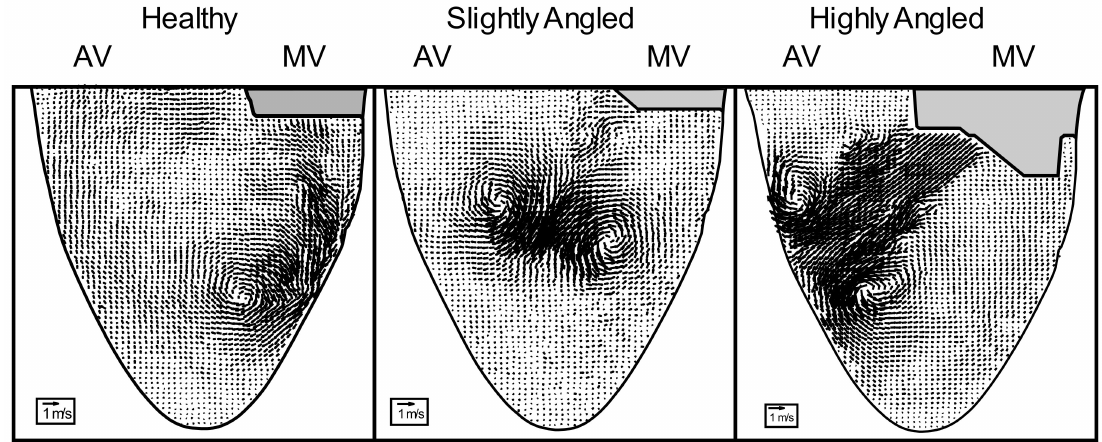
Figure 5. Vector field portraying the different inlet jet for the different orientation of the mitral valve. The corresponding time of the cycle at which this occurs is t * =